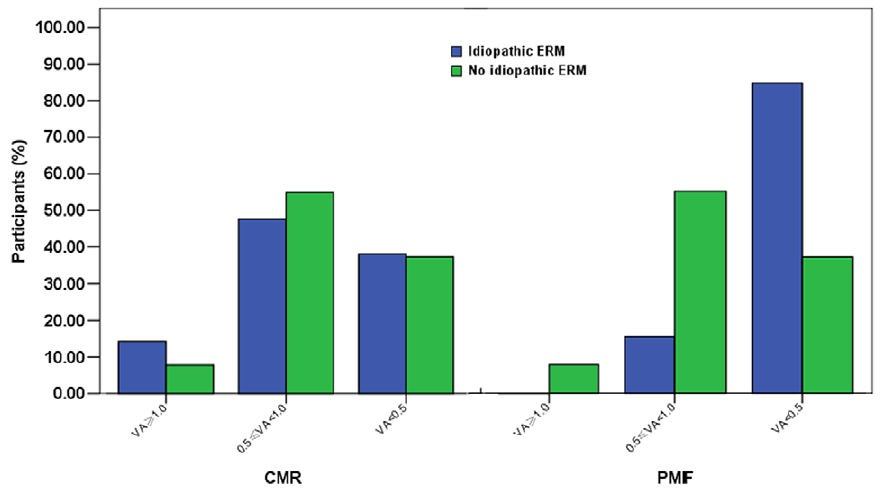
Figure 1. LogMAR presenting visual acuity of idiopathic epiretinal membranes (iERM) and no iERM.